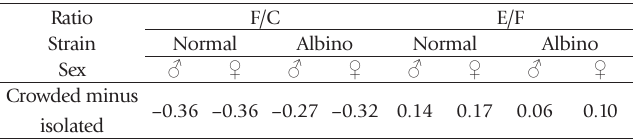
Table 5. Shifts in the average values of the morphometric ratios from crowding to